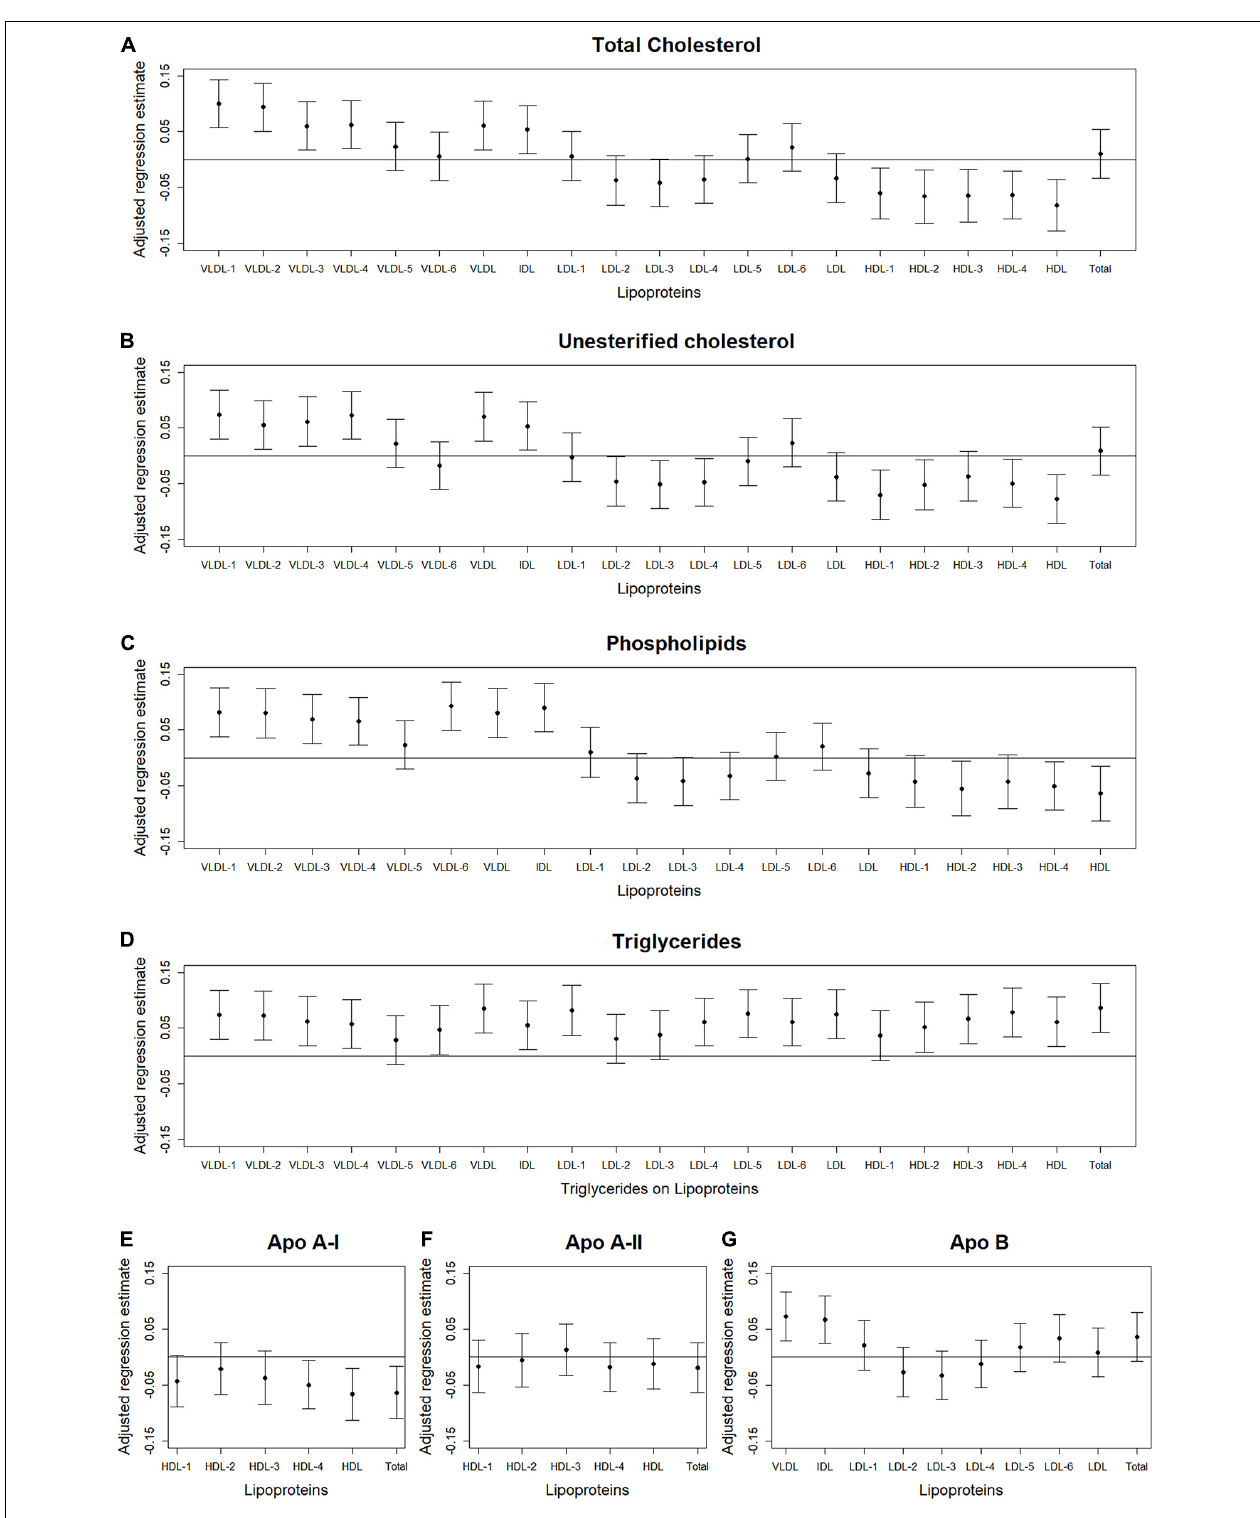
FIGURE 2 | Total abdominal muscle area: Scatterplots of the adjusted associations between 105 lipoprotein subfractions and muscle area ordered from lowest to highest density lipoprotein subfraction and by total cholesterol (A) , unesterified cholesterol (B) , phospholipids (C) , triglycerides (D) , apo A-I (E) , apo A-II (F) , and apo B (G) among 947 MESA